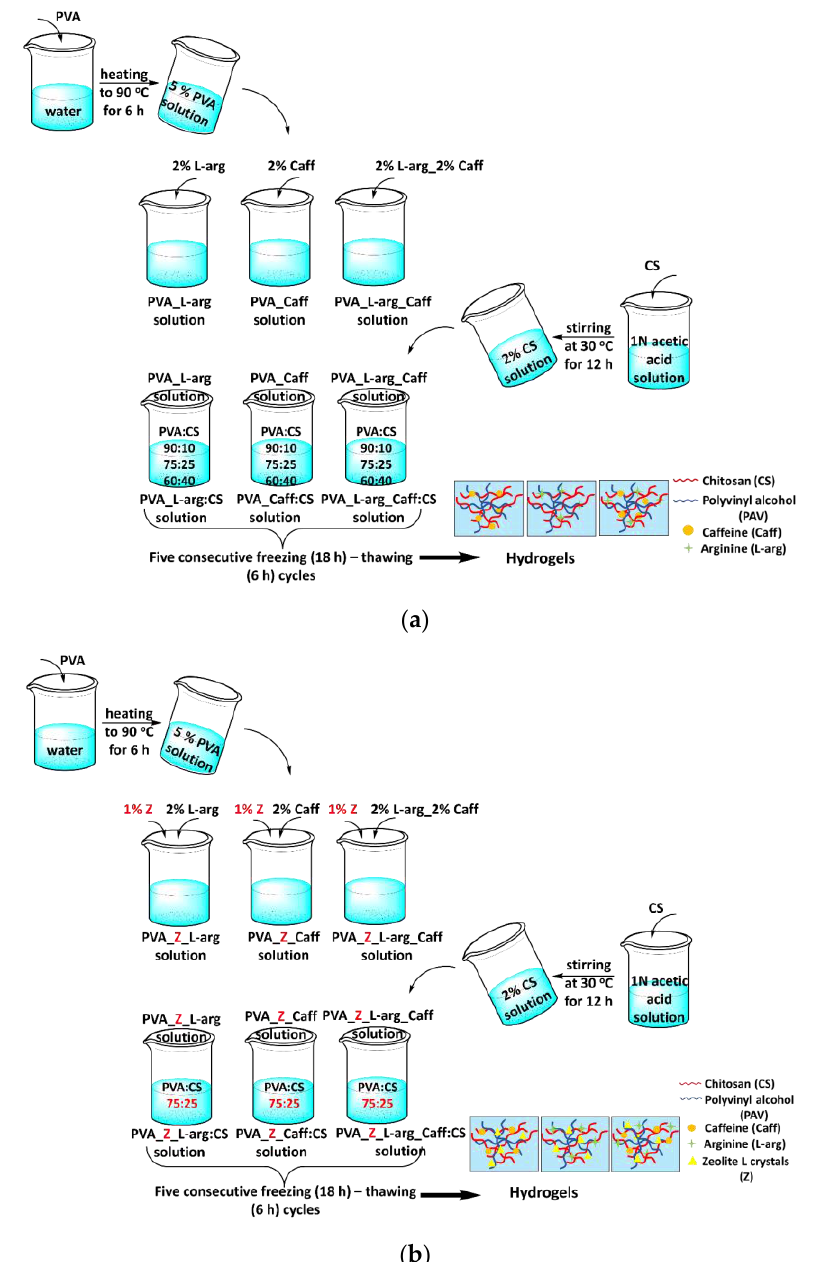
Figure 6. Experimental presentation of obtaining hydrogels: ( a ) without zeolite and ( b ) with zeolite .